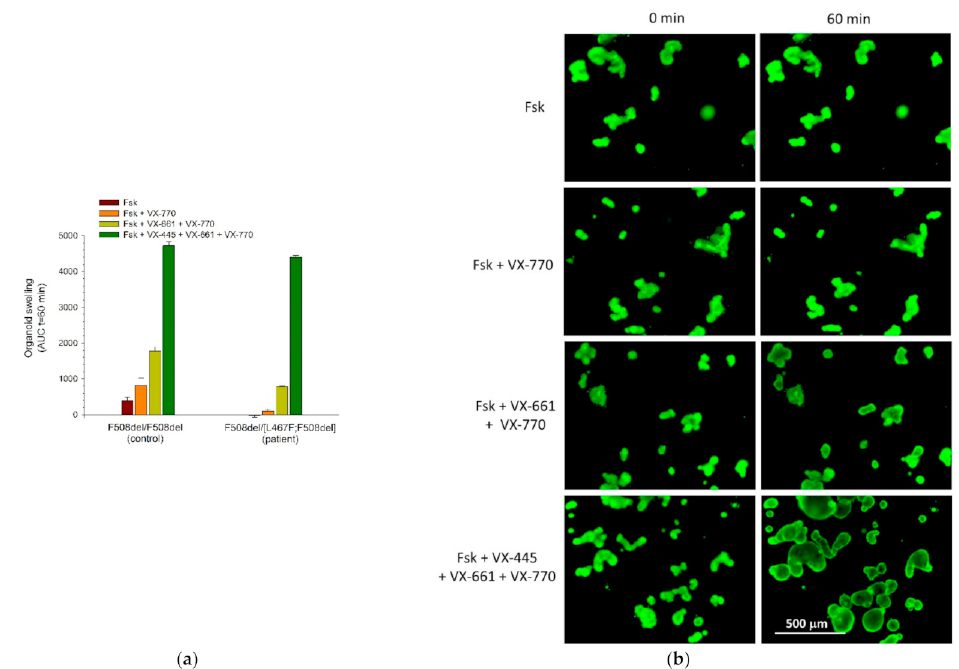
Figure 5. Assessment of the residual CFTR function and the effectiveness of the CFTR modulators ( a ) Quantitative evaluation of FIS results of intestinal organoids with a complex allele [L467F;F508del] in comparison with control F508del/F508del organoids. Fsk—forskolin, VX-770—ivacaftor, VX-661— tezacaftor, and VX-445—elexacaftor. ( b ) Representative images of intestinal organoids obtained from a patient with the genotype F508del/[L467F;F508del] before exposure to forskolin (5 µ M) and after treatment. Concentration of all CFTR modulators—3.5 µ M; staining—calcein (0.84 µ M, 40 min), and scale bar—500